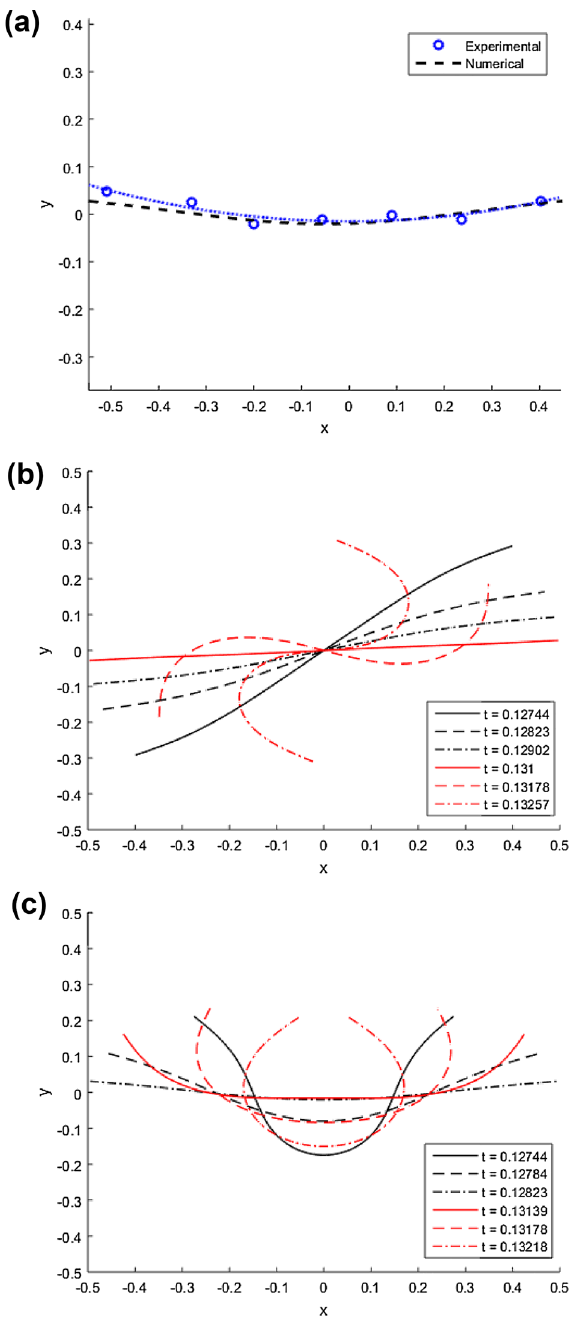
Figure 2. ( a ) Relaxed filament shapes obtained from experimental data and numerical simulations. For dashed line, Cm = 30 and T /τ = 0.0013 . The circles donates particle centres of experimental data with L = 48 µ m and H = 5.2 Oe. ( b , c ) Filament shapes obtained by numerical simulations, red and black lines donates the configuration during bending and relaxation stage respectively within one period at different time moments t ; Cm = 70 and T /τ = 0.0052 . ( b ) and ( c ) shows the difference of results without and with the condition of curved initial shape